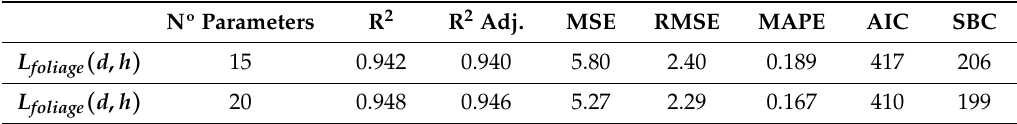
Table 6. Evaluation parameters comparison of the regularized optimization carried out for 15 and 20 parameters.